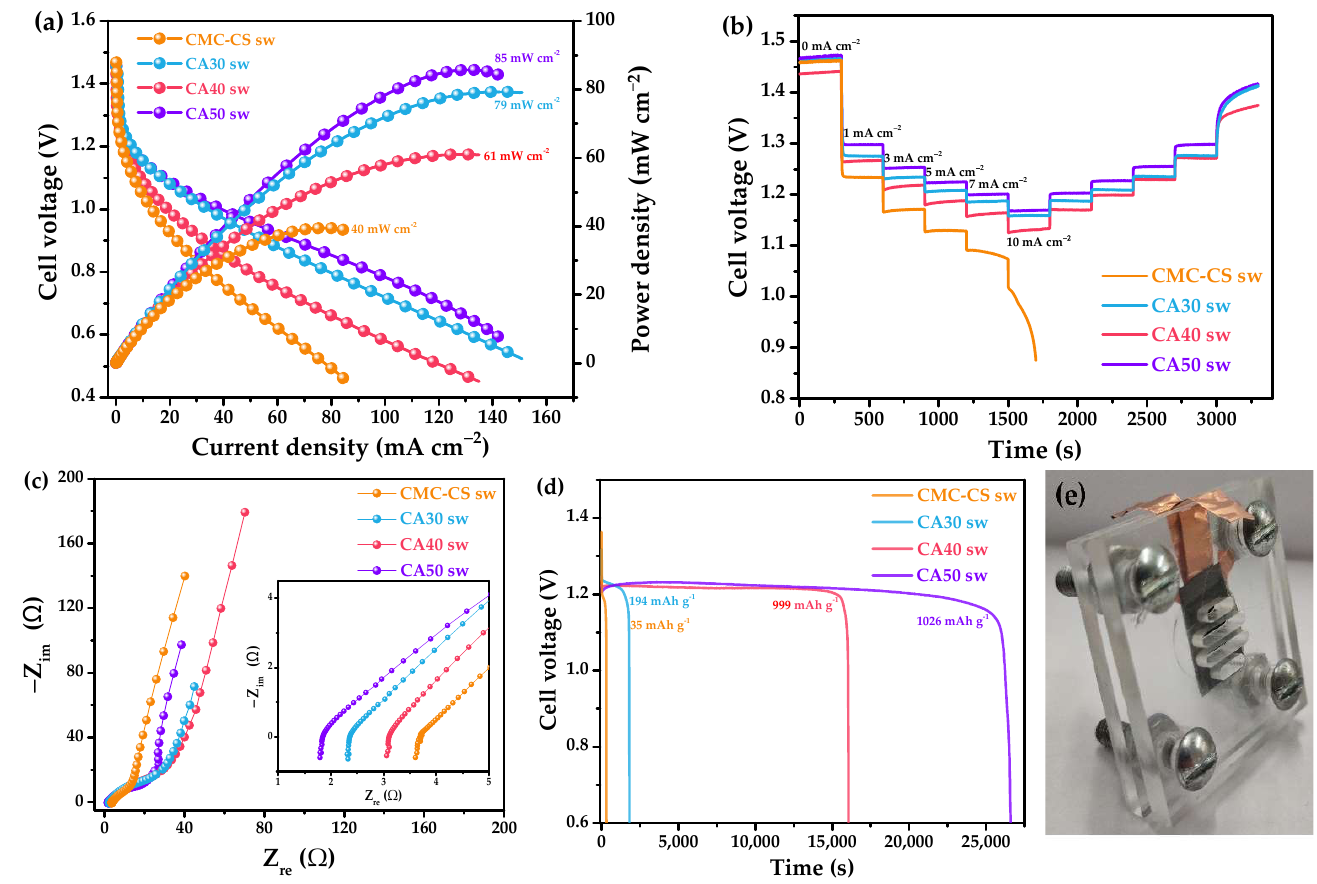
Figure 10. ( a ) Discharge and power density curves for the battery operated with the Zn foil as an anode and Pt/C as a cathode and the synthetized hydrogels; ( b ) discharge tests at selected current densities; ( c ) potential electrochemical impedance spectroscopy studies; ( d ) discharge performance at 3 mA cm −2 ; ( e ) photograph of the assembled device. Table 4. Battery performance of some Zinc–air batteries with polymer electrolytes. Ionic Electrolyte